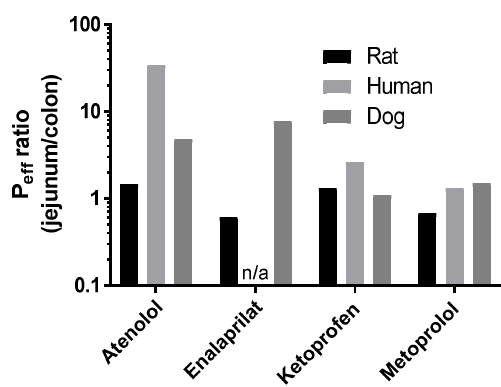
Figure 3. The P e ff ratio between the jejunum and colon at pH 6.5 in rat of atenolol, enalaprilat, ketoprofen, and metoprolol (Table 2). The historical human and dog P e ff ratios between the jejunum and colon at pH 6.5 of atenolol, enalaprilat (not human), ketoprofen, and metoprolol are also presented for species comparison [4,19].